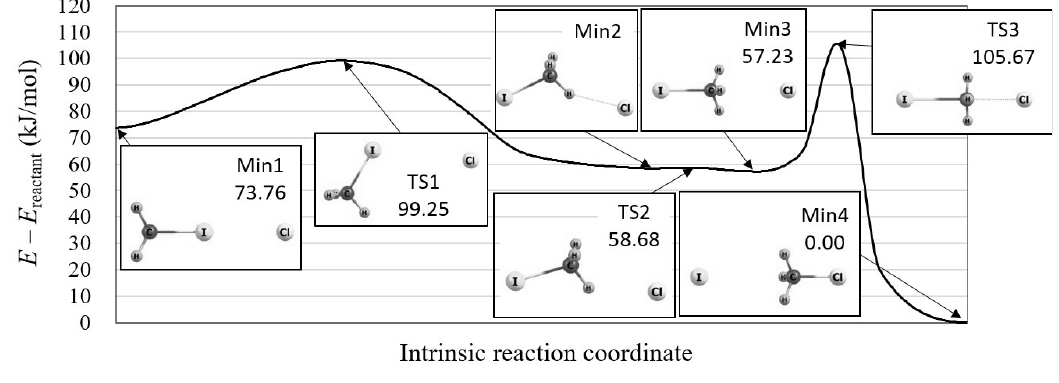
Figure 3. The potential energy curve of the overall Cl − + CH 3 I → CH 3 Cl + I − reaction including its precursor process, which is calculated by the reaction path search method in the GRRM program with LC-BOP+LRD/Def2-TZVPD. The molecular structures are also shown for the local minima (Min) and transition states (TS) on the potential energy